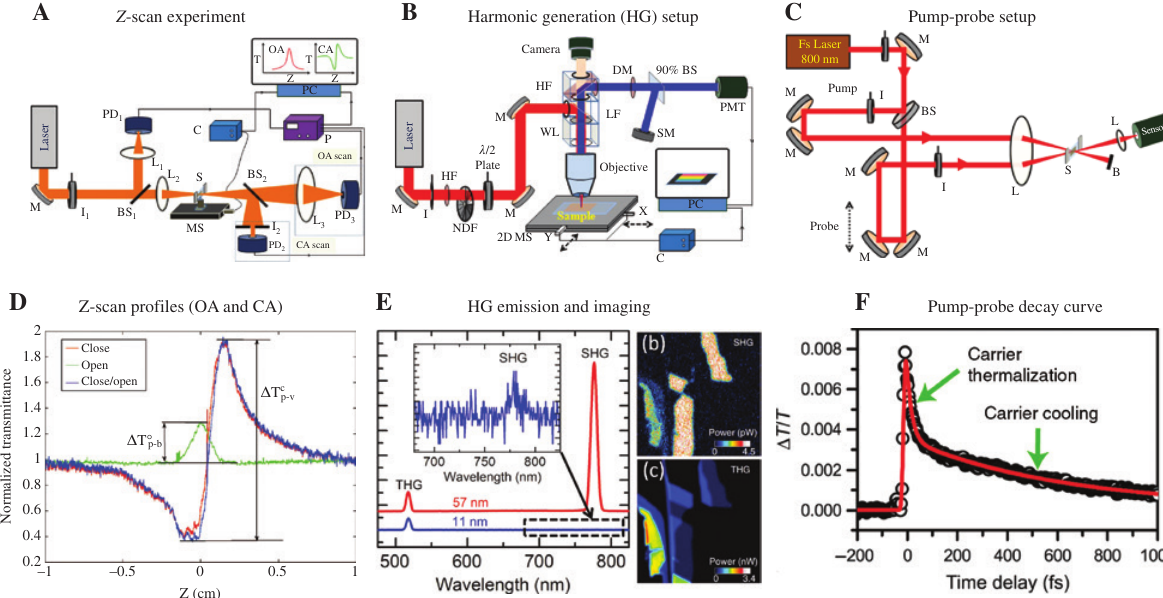
Figure 6: Setups for nonlinear optical measurements. (A–C) Optical layouts of a typical Z -scan, HG, and PP techniques. M, mirror; I, iris; BS, beam splitter; L, double-convex lens; S, sample; HF, high-pass dichroic filter; LF, low-pass dichroic filter; WL, white light illumination; DM, dichroic mirror; PD, photodetectors; MS, motorized stage; C, controller; P, power meter; SM, spectrometer; PMT, photomultiplier tube; 2D MS, 2D micromover stage. (D) Typical open aperture (E) HG (SHG and THG) emission spectra [70] and spatial mapping images of 2DLMs obtained from an HG setup [71]. Reproduced